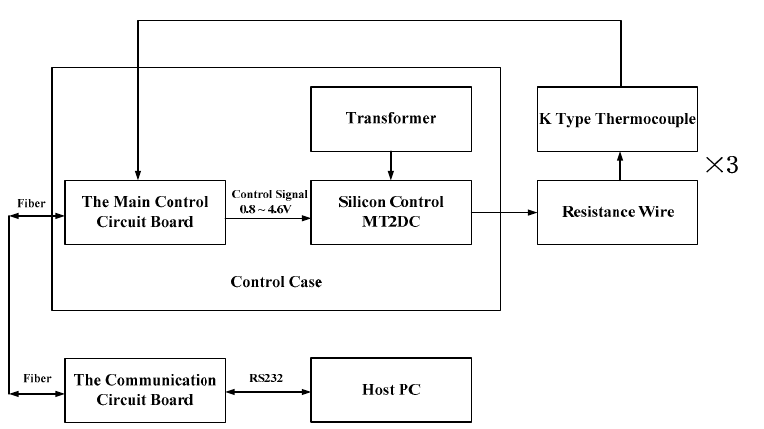
Figure 3. The block diagram of constant temperature control system.